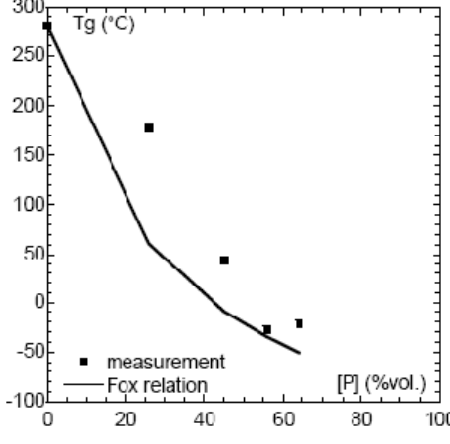
Figure 4. Tg of SPSFNa (IEC = 1.3 Na + /kg) /sorbitol blends versus sorbitol content.